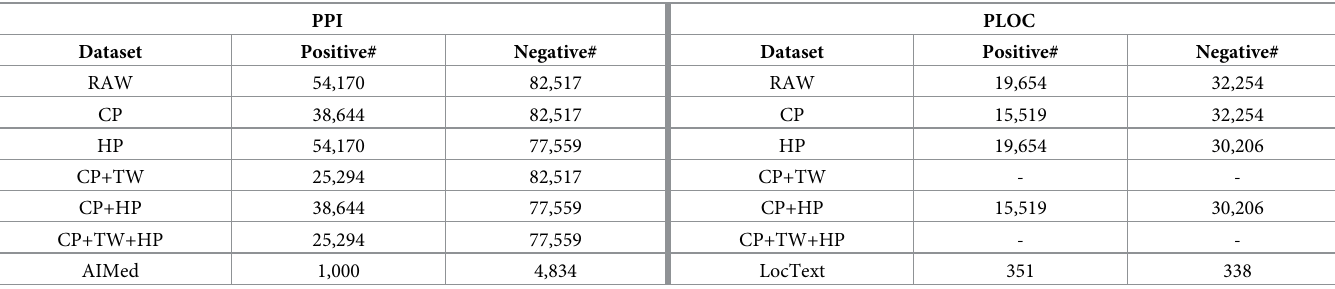
Table 1. DS data and test data statistics.